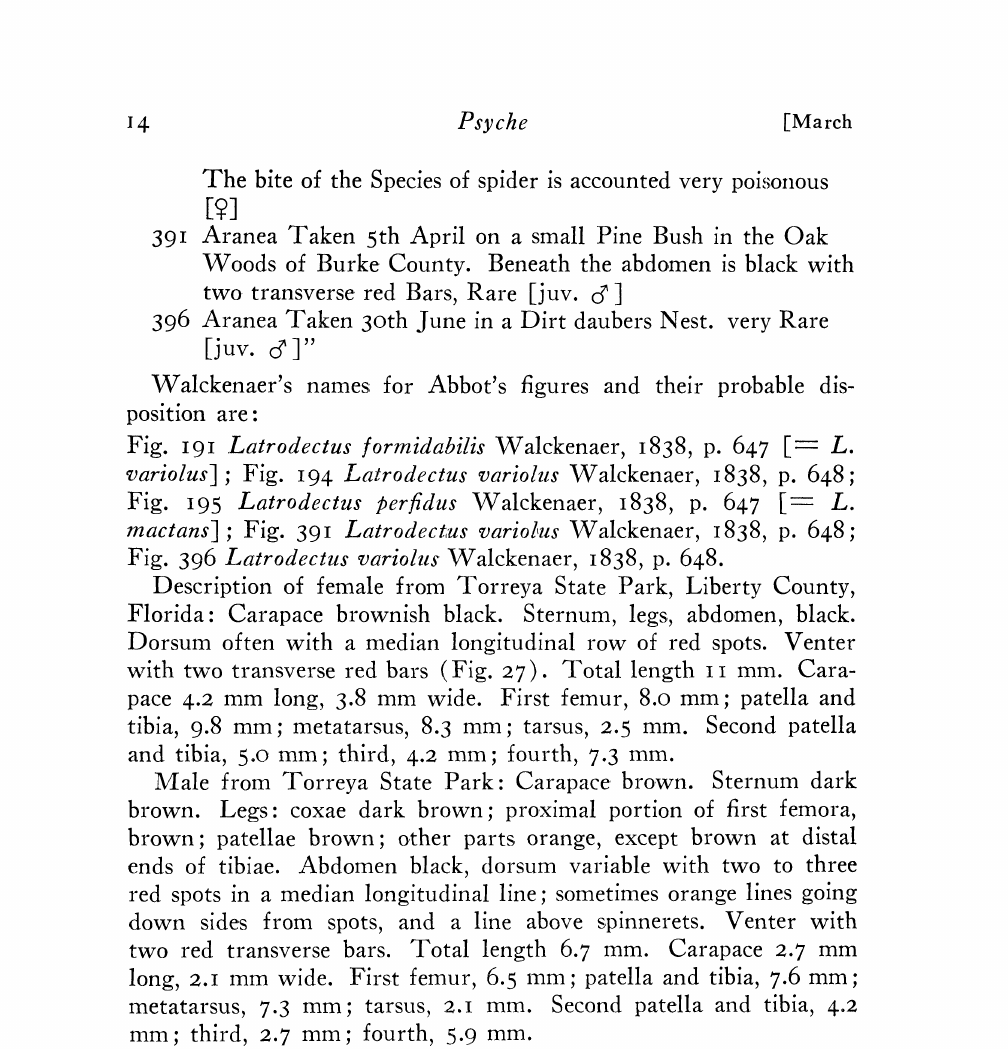
black with ]our dorsal spots in a longitudinal median row and some spots on sides. Venter with two transverse marks, probably red